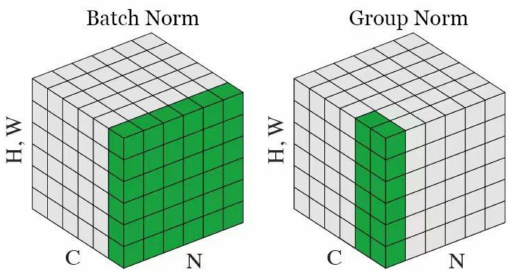
Figure A1. Two Normalization methods. The feature map tensor is shown in each